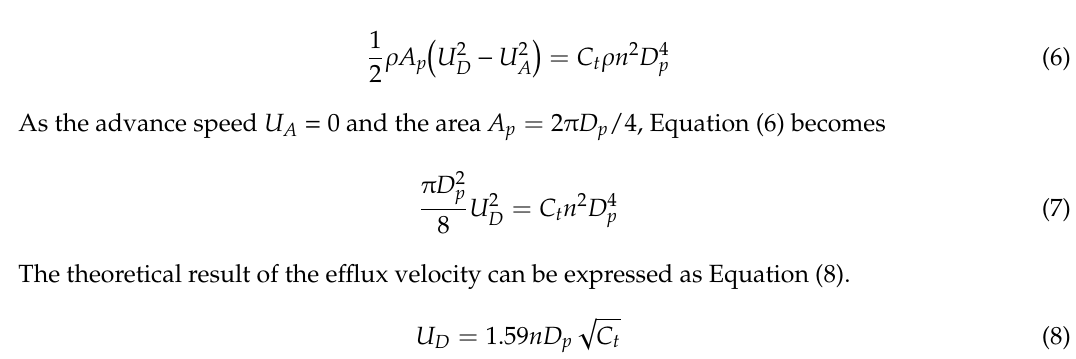
Table 3. Comparison of current study and previous studies on efflux plane. Source Equation